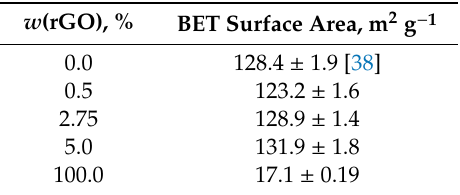
Table 2. Surface areas of TiO 2 and S-TiO 2 / rGO composites determined by Brauner Emmett Teller (BET) analysis, with pristine TiO 2 being denoted as w (rGO) = 0% and rGO with w (rGO) =